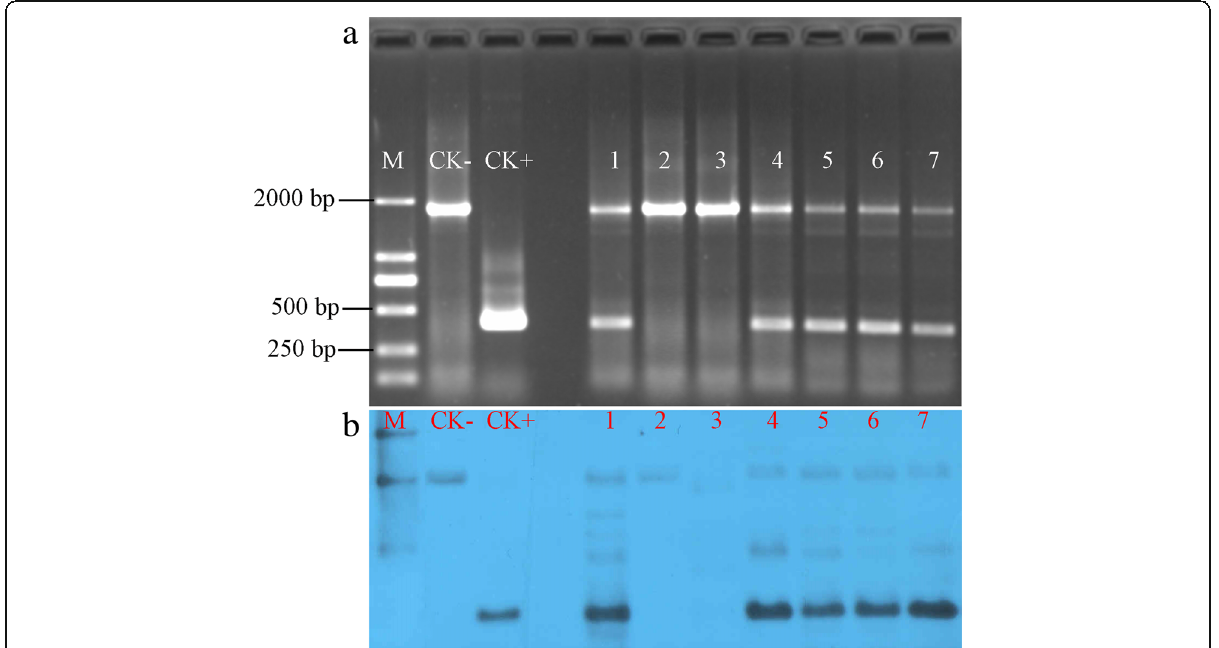
Fig. 3 Molecular identification of transformants. a PCR analysis of T 0 transformants shows the presence of the 1761 bp PTB1 gene in the rice genome (CK-), 412 bp fragment of PTB1 CDS in the pFS4 plasmid (CK+), and both 1761 bp and 412 bp fragments in T 0 transgenic plants. b Southern blot analysis to confirm insertion of T-DNA in transformants. Genomic DNA from a non-transgenic plant (CK-), the pFS4 plasmid (CK+), and T 0 generation transformants (1 – 7) were digested with EcoR I and hybridized with the PTB1 CDS probe. Southern blots show that PTB1 CDS sequence was stably integrated into the genomes of transgenic